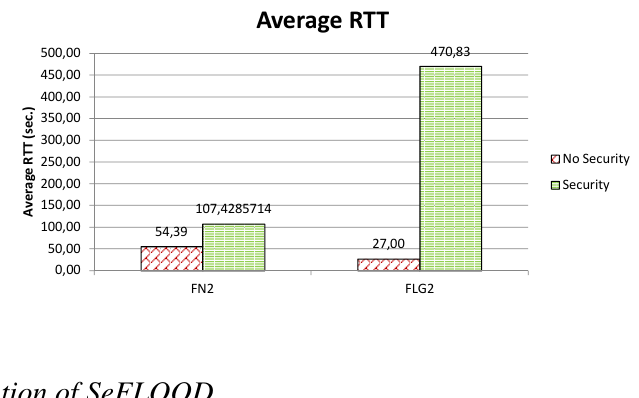
Figure 11. Average round-trip time when security is enabled/disabled.